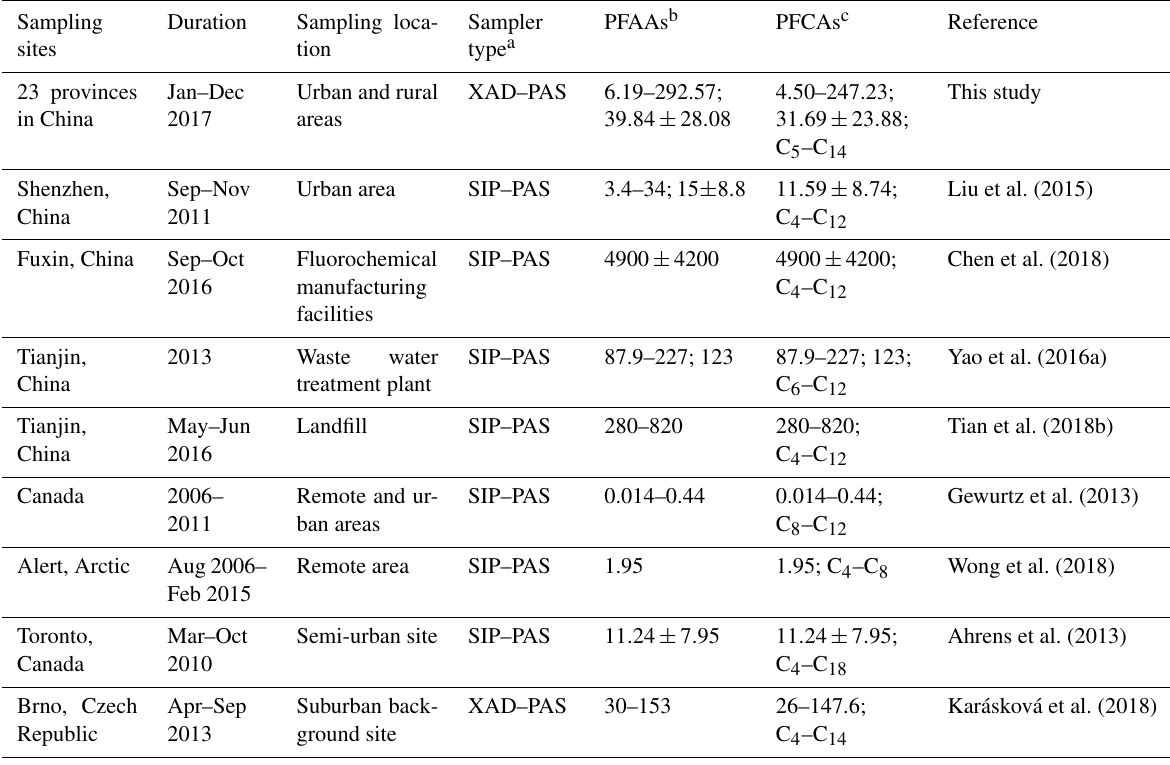
Table 1. Comparison of PFAAs levels in the present research with measurements in other areas (pgm − 3 ).